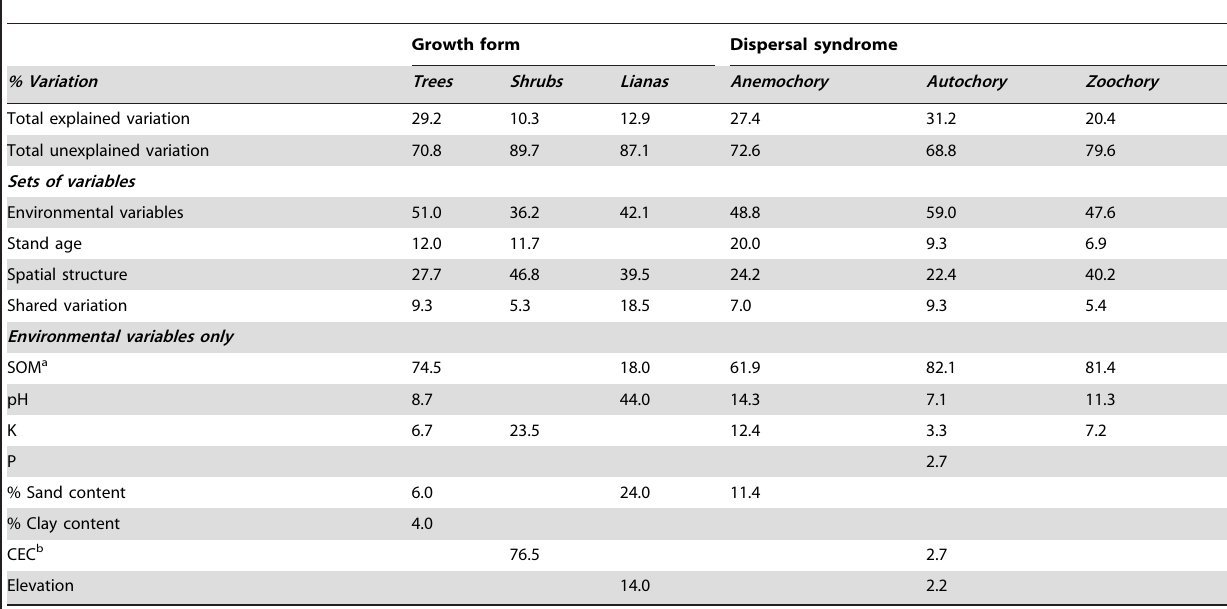
Table 3. Variation partitioning (percentage) of b -diversity by plant growth form and dispersal syndrome through partial Redundancy analysis (RDA). Only significant variables ( P , 0.05) are